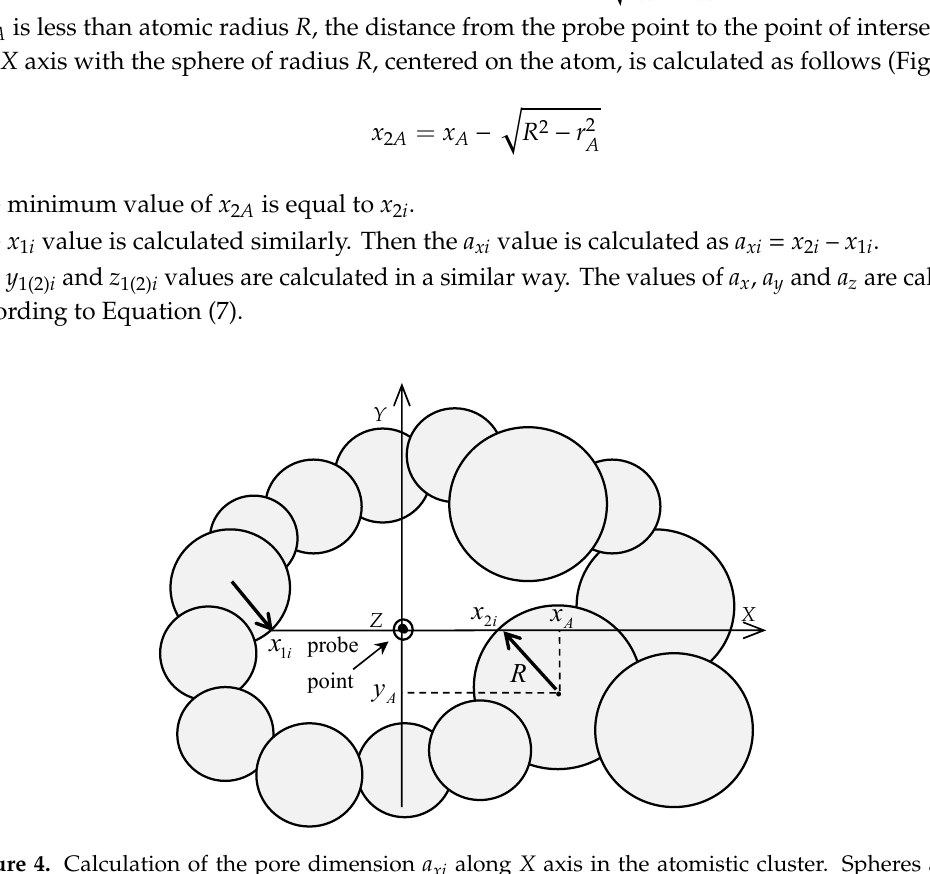
Figure 4. Calculation of the pore dimension a xi along X axis in the atomistic cluster. Spheres are centered on the atoms. The sphere radius depends on the chemical element to which the atom belongs.